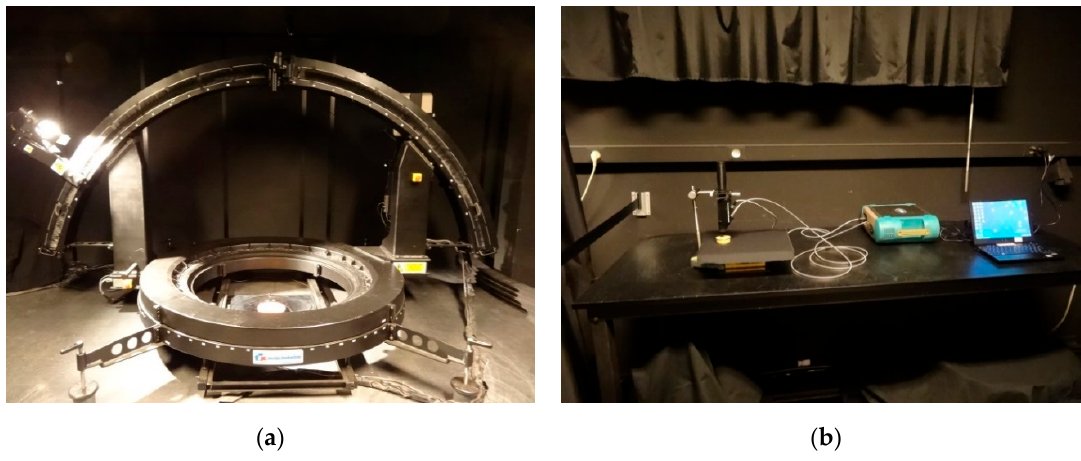
Figure 1. Measurement devices: ( a ) ONERA BCRF measurement device named “Banc de BRDF grands échantillons”; ( b ) 1 geometry BCRF measurement set up using a contact probe .